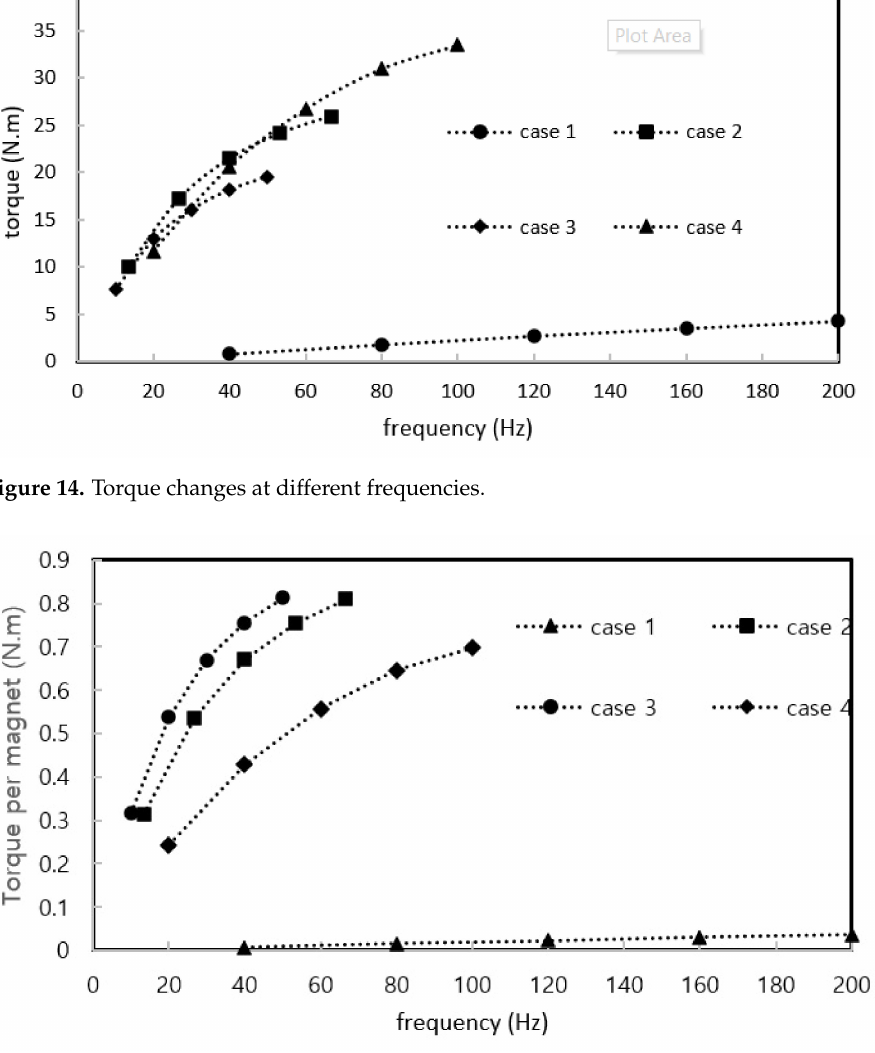
Figure 15. Torque per magnet changes at different